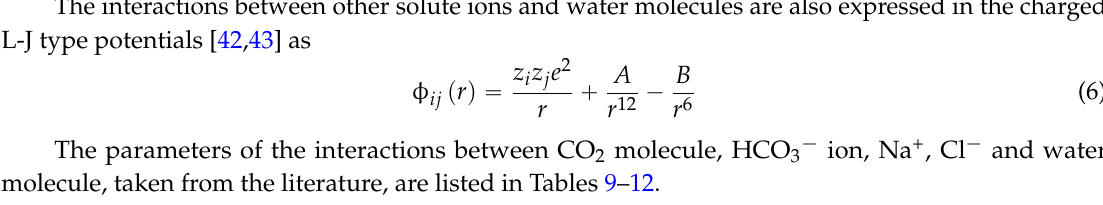
Table 9. The potential parameters between CO 2 –CO 2 , CO 2 –Na + , CO 2 –Cl ´ , and CO 2 –TIP4P